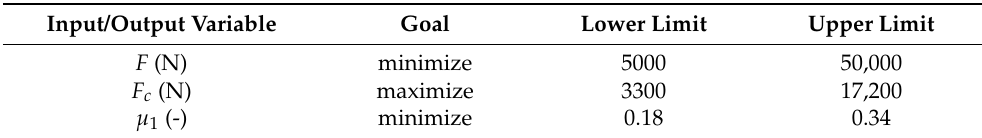
Table 1. Breakdown of the optimization criteria for the compaction process parameters considering the compaction force F , coefficient of friction µ 1 and the characteristics of the obtained briquette expressed as the force F c .